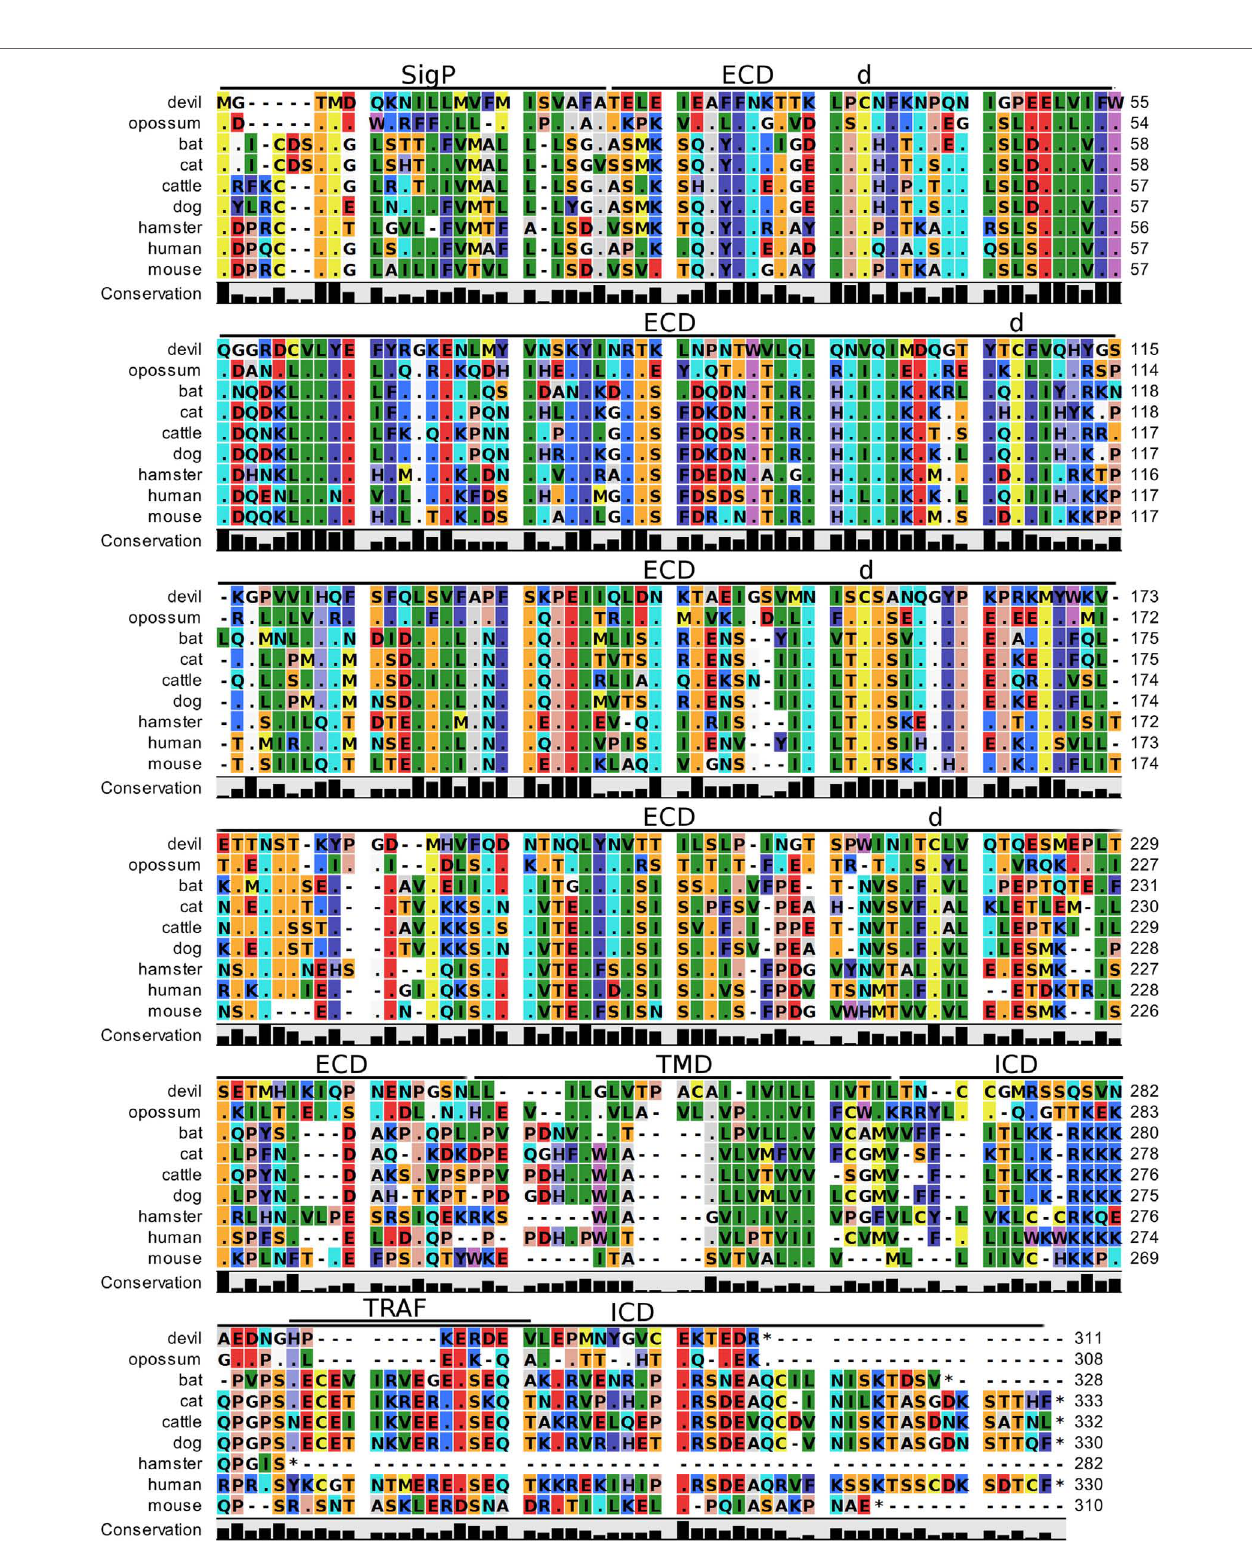
FigUre 5 | alignment of cD86 reference genes for nine species . The predicted signal peptides (SigP), extracellular domain (ECD), transmembrane domain (TMD), and intracellular domain (ICD) are demarcated with bars. “d” above the alignment represents predicted disulfide bonds. TRAF indicates a putative TRAF6- binding site. The black bar graphs below the alignment represent the conservation of amino acids across all nine species. The percent amino acid sequence identity between devils and other species is shown in the bottom right corner of the alignment. See Table 2 for the sequence identity between devils and other